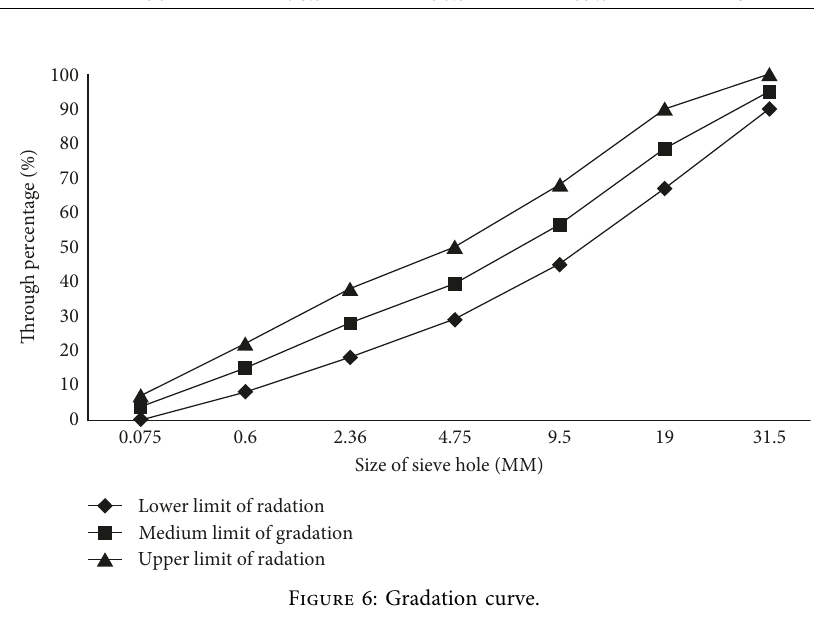
Figure 6: Gradation curve.